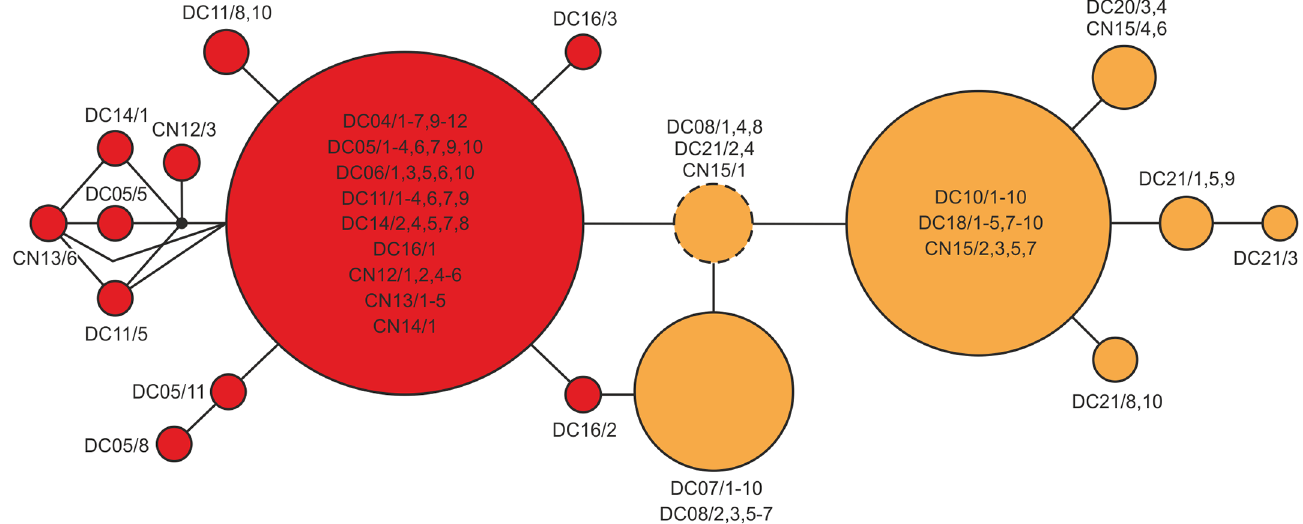
Fig 2. Statistical parsimony network of Lake Donggi Cona Radix specimens based on mtDNA data. All haplotypes inferred are endemic to the Lake Donggi Cona drainage system. Red circles: lake specimens, orange circles: drainage specimens. Specimen and location details are given in the Supplement (see S1 Table). The most probable ancestral haplotype is indicated by a dashed line.